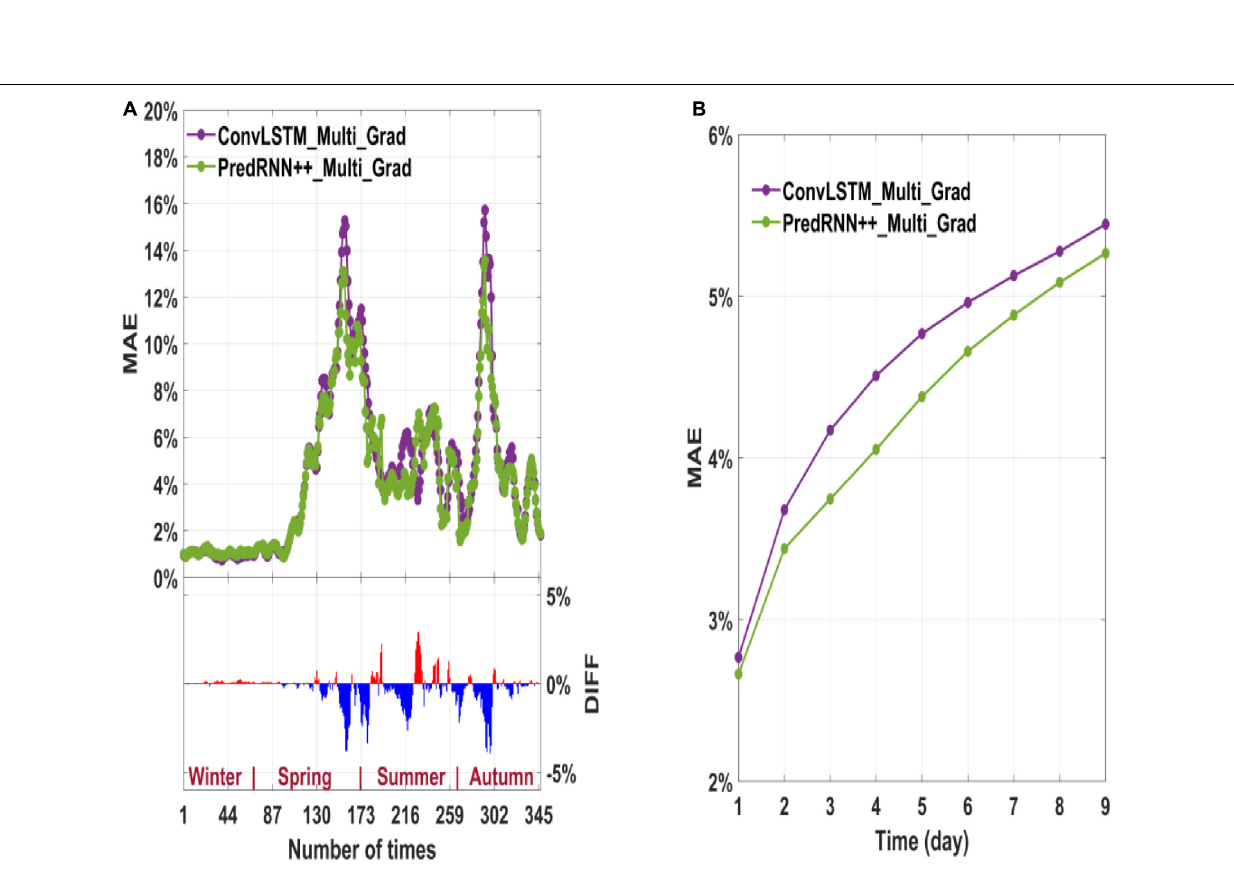
Frontiers in Marine Science |